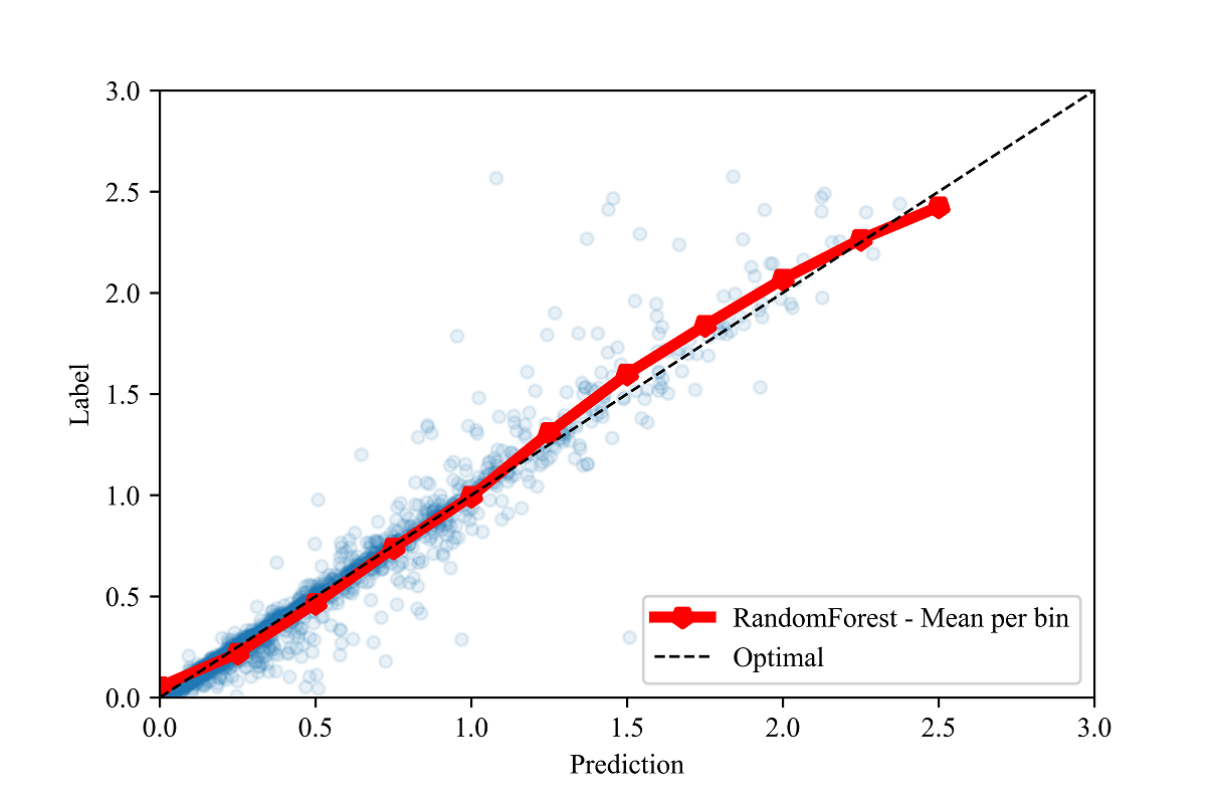
Figure 2. Calibration plot between the labels and predictions for the interpolation validation method, with the mean of each prediction bin of size